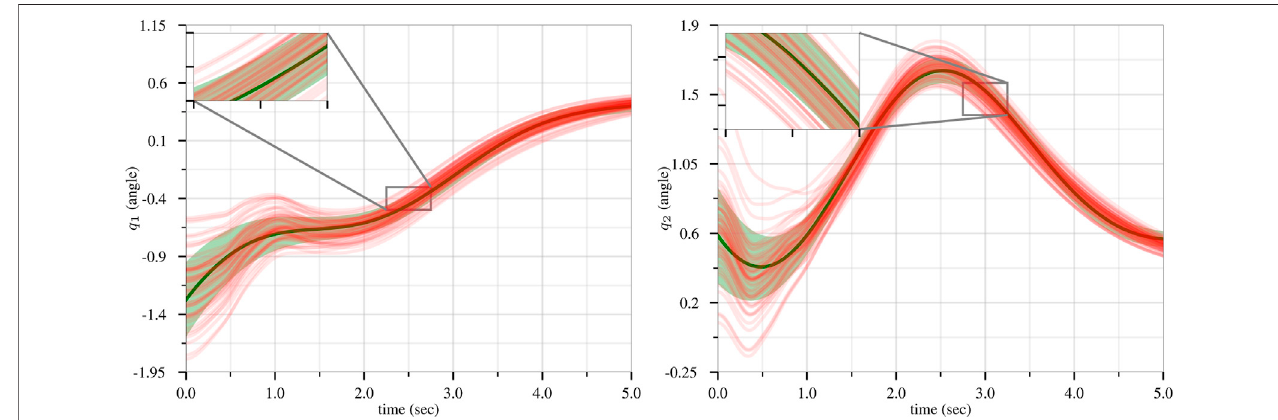
FIGURE 3 | Training of the CLF/CBF-based ProMPs for the fi rst joint (left) and second joint (right). The 50 input trajectories are shown in red, and the ProMP mean joint trajectories ( μ